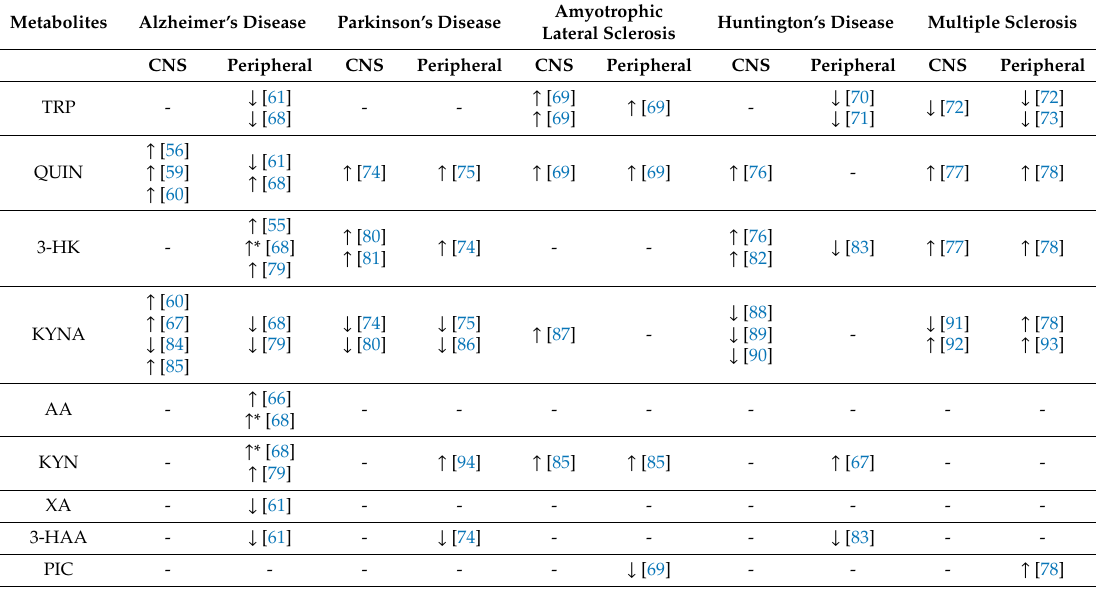
Table 1. Changes of metabolites of the kynurenine pathway in neurologic diseases. ↑ : increase, ↓ : decrease, *: tendency, not statistically